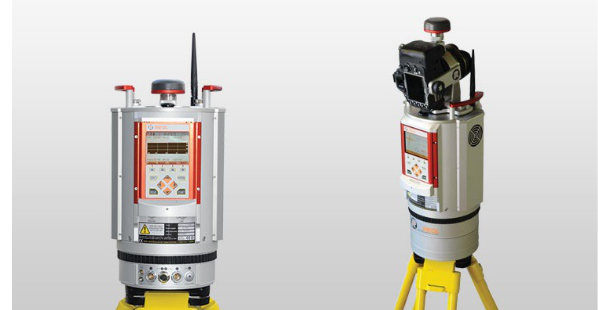
Figure 3. VZ-2000 terrestrial LiDAR